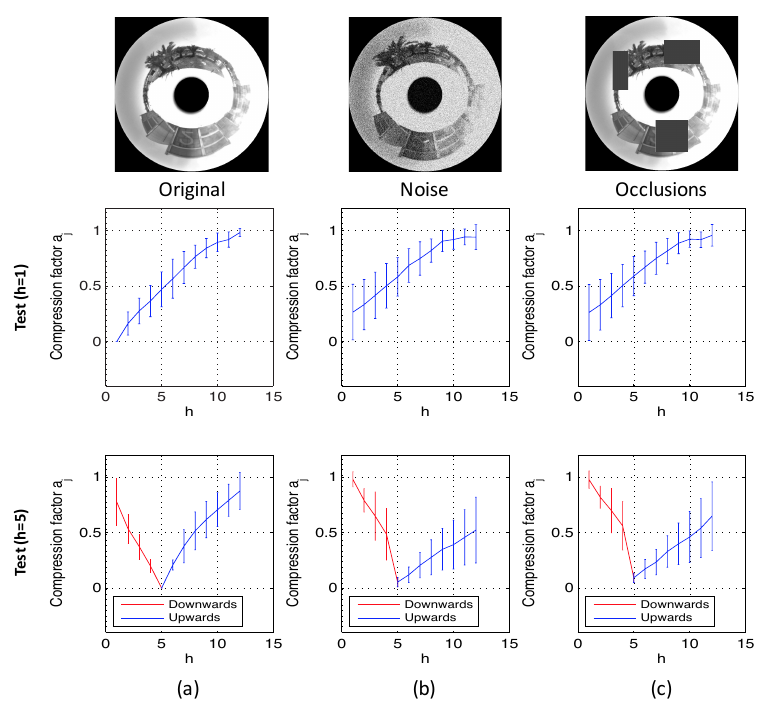
Figure 18. Altitude estimation using the method based on SURF features and the outdoors database, using reference images at the bottom (h = 1) and in the middle of the height (h = 5). Average and standard deviation of all locations considering ( a ) the original test images, ( b ) noise added to the test images, and ( c ) occlusions added to the test images.